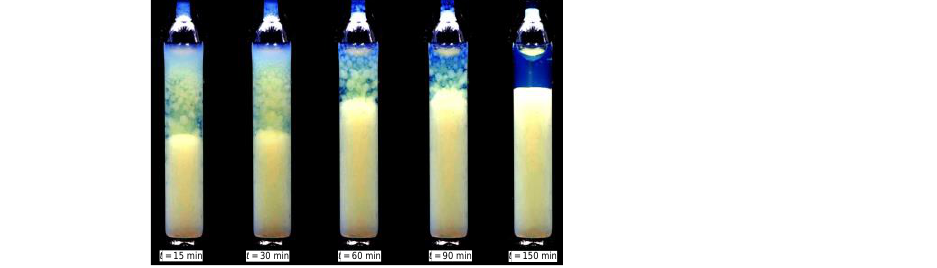
Figure 3. The time-dependent creation of coexisting phases in MBBA—Isooctane mixture two-phase ( 2P ) domain: 𝑥 = 0.1 𝑚𝑜𝑙 𝑓. isooctane, for the temperature 𝑇 2𝑃ℎ𝐼 − 1𝐾 . The photo is after numerical filtering to reach insight into the sample’s interior (see Section 4).